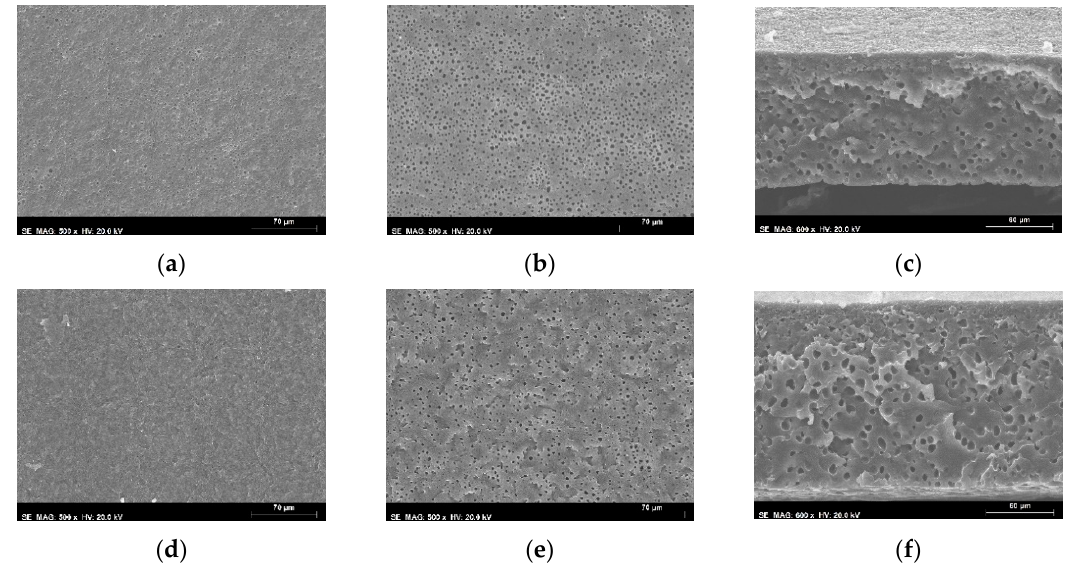
Figure A2. SEM images of the integral asymmetric PU5-5 and PU5-10 membranes: ( a ) top surface of PU5-5, ( b ) bottom surface of PU5-5, ( c ) cross-section of the of PU5-5; ( d ) top surface of PU5-10, ( e ) bottom surface of PU5-10, ( f ) cross-section of PU5-10.